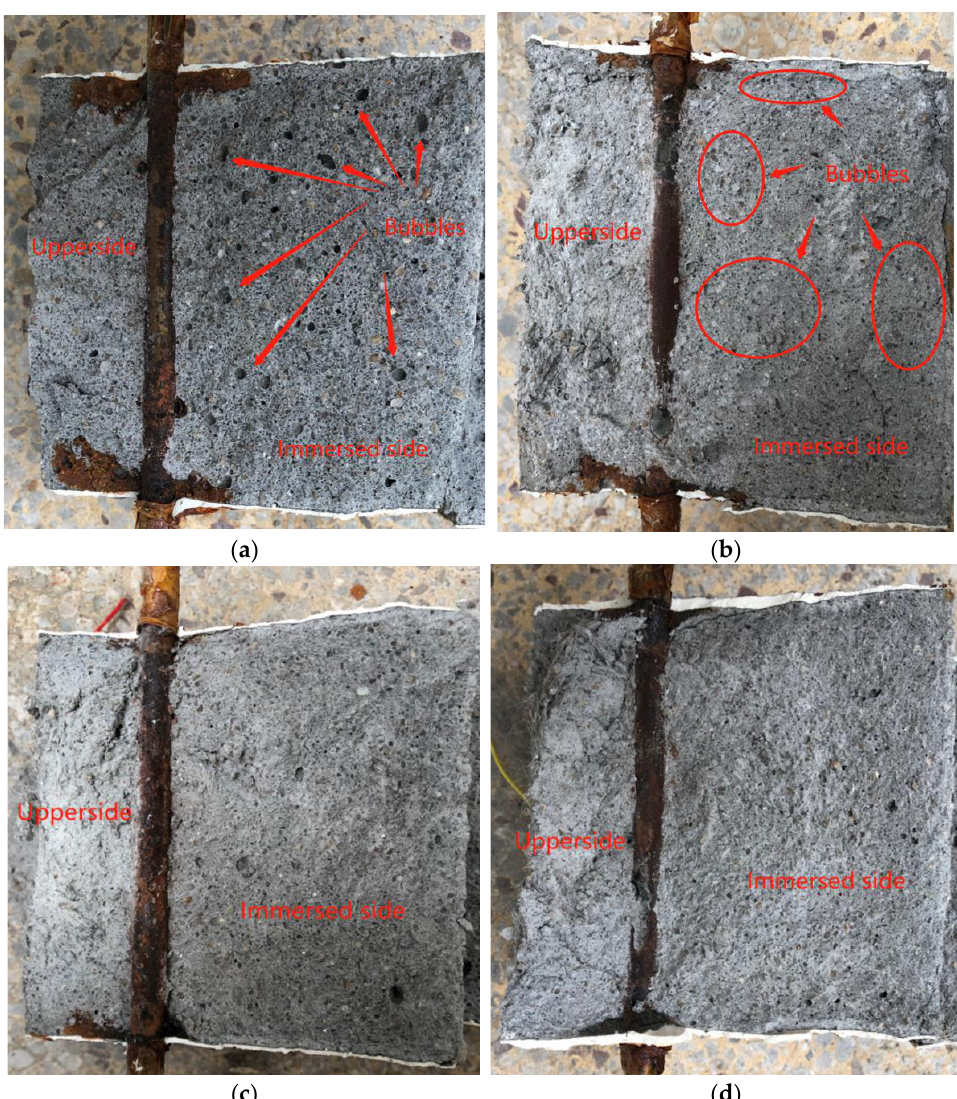
Figure 12. Distribution of rust in the splitting mortar: ( a ) FA; ( b ) PVA; ( c ) NS1.0; ( d ) NS1.5.